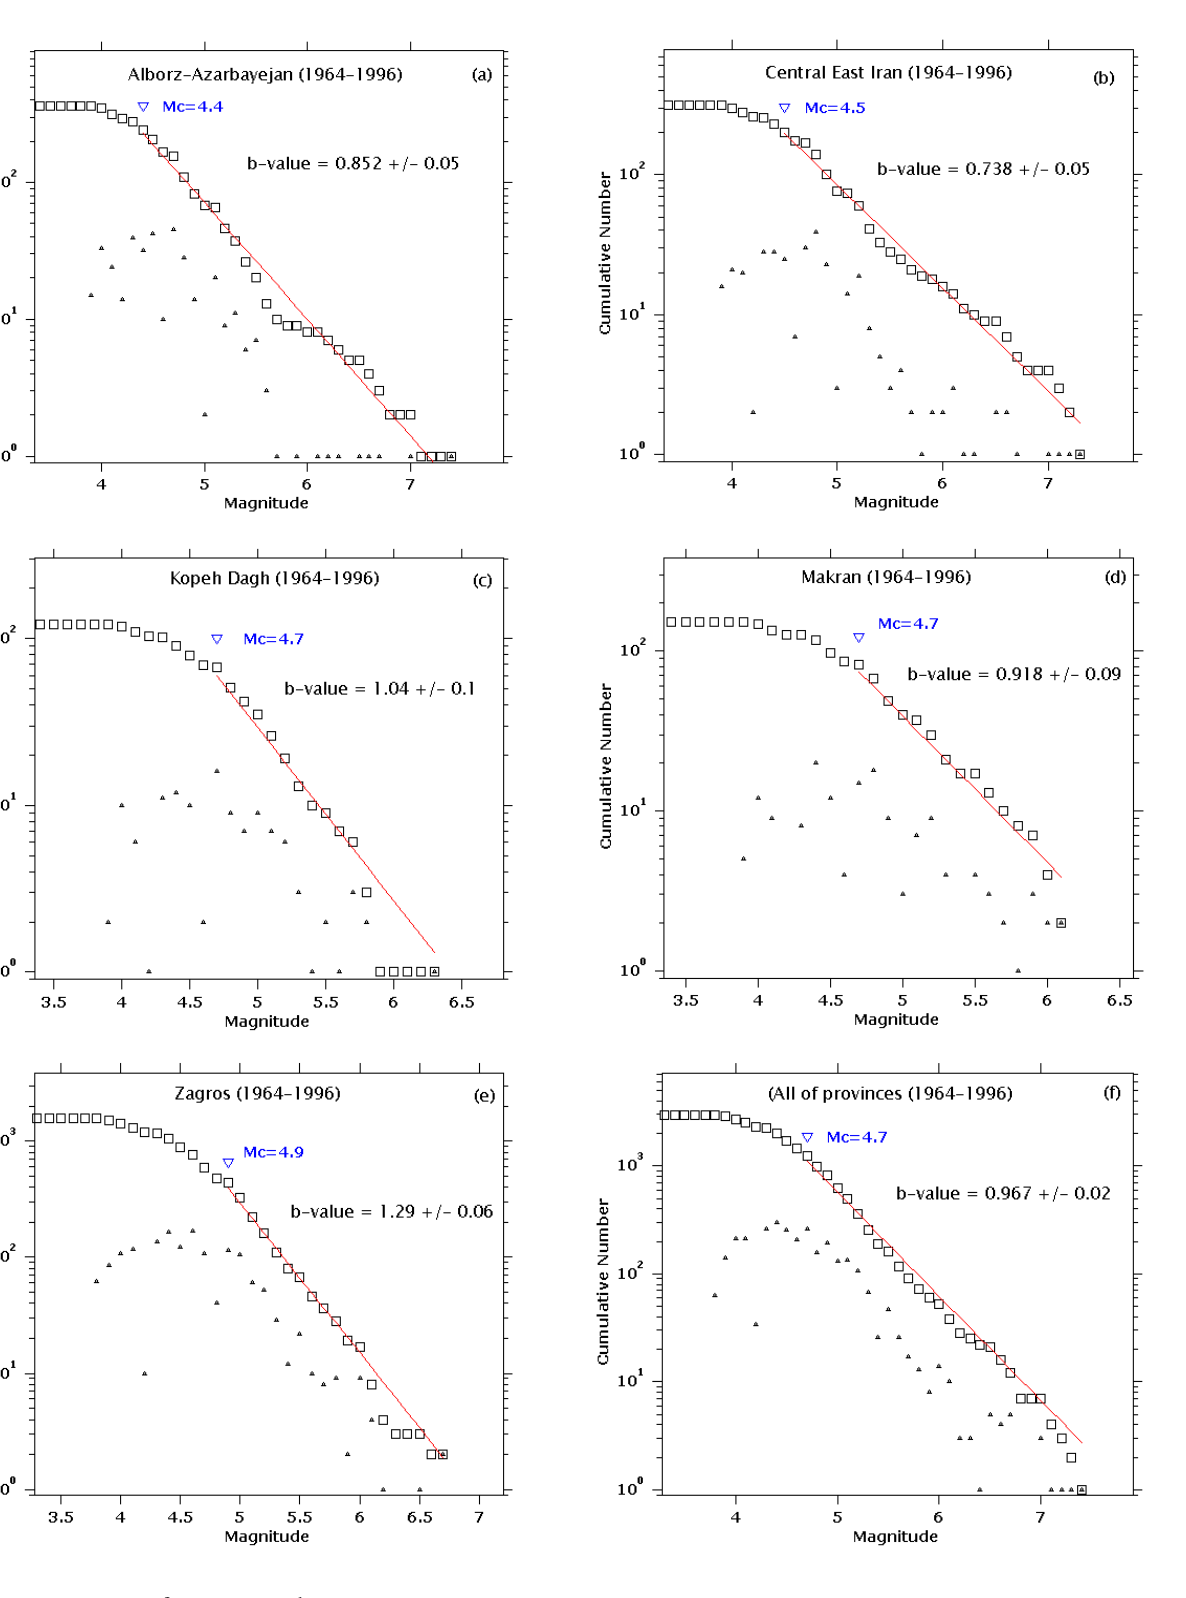
Figure 15. As Figure 14 for time interval